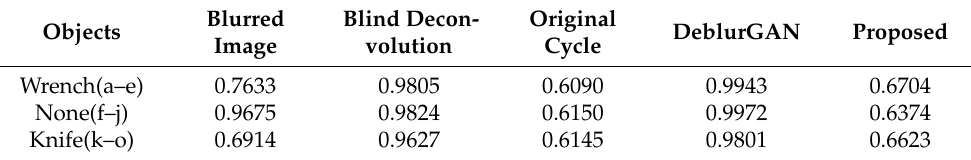
Table 1. Comparison of entropy of the results using different deblurring